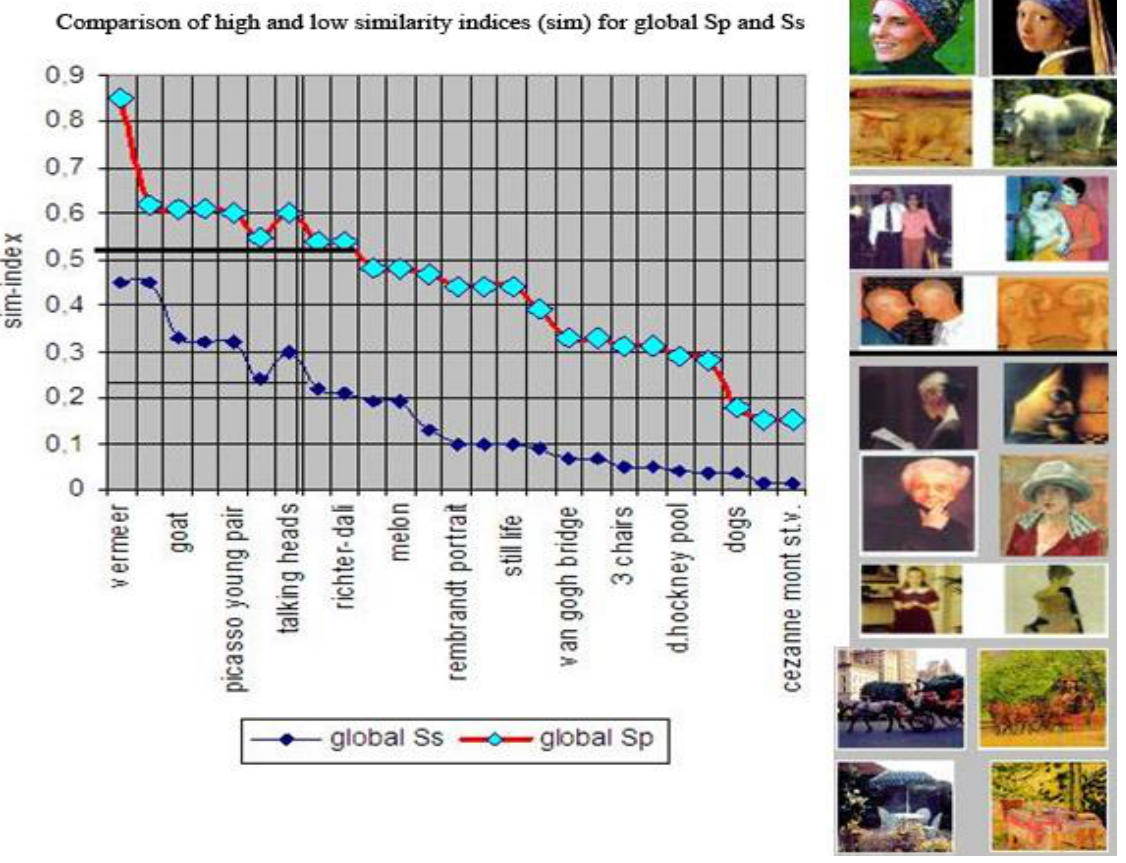
Fig.5b : Parsing Diagram of similarity of sequence (Ss) of repetitive (R), local (L), idiosyncratic (I) and global (G) conditions. Note the the high similarity index for R and L as expected from previous findings; also note the low similari- ty index for I and R that is in the range of the standard deviation; blue column: average sim value; red column: stand- ard deviation; yellow column: